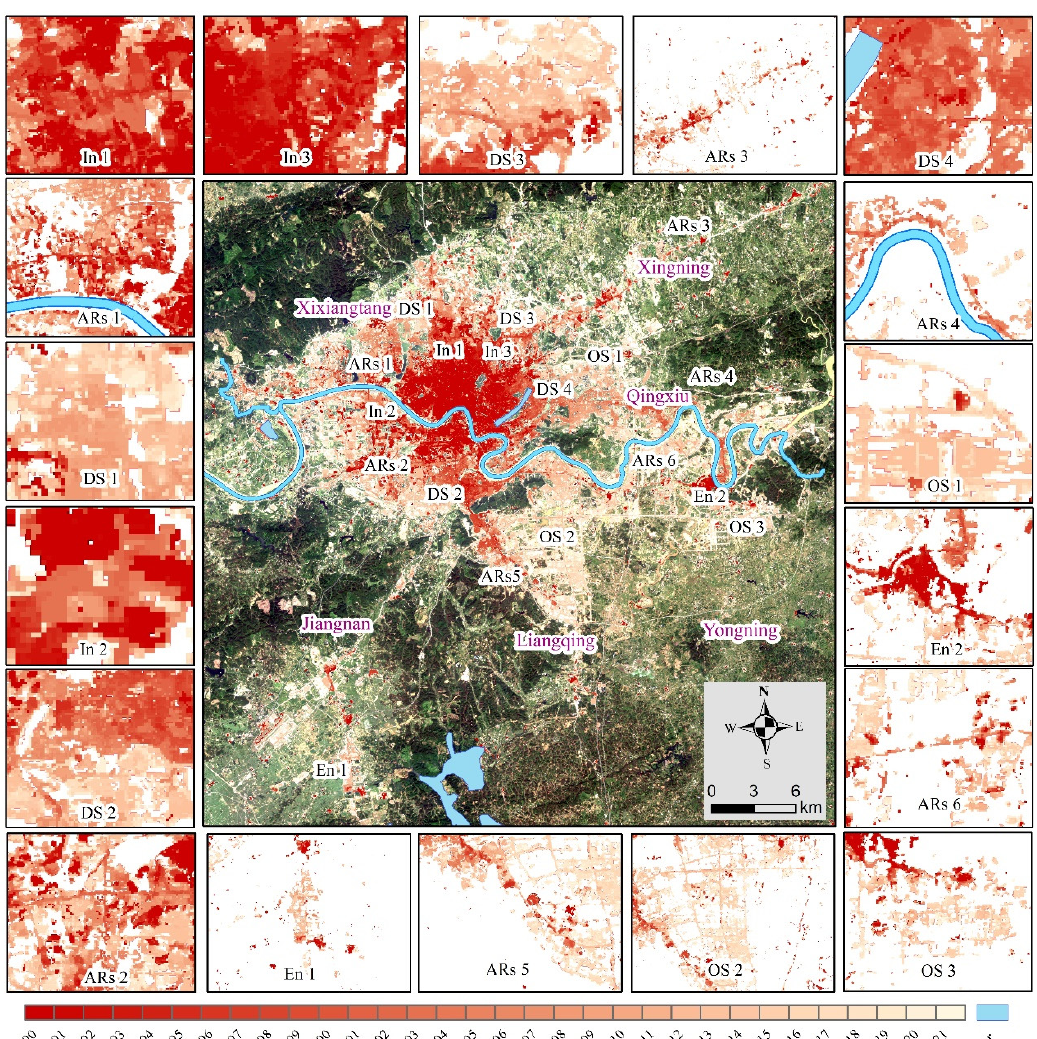
Figure 6. Spatial expansion mode of construction land in Nanning (In, Ars, DS, OS, and En denote infill spreading, finger-like expansion along roads, disorderly spreading, orderly spreading, and enclave spreading, respectively).